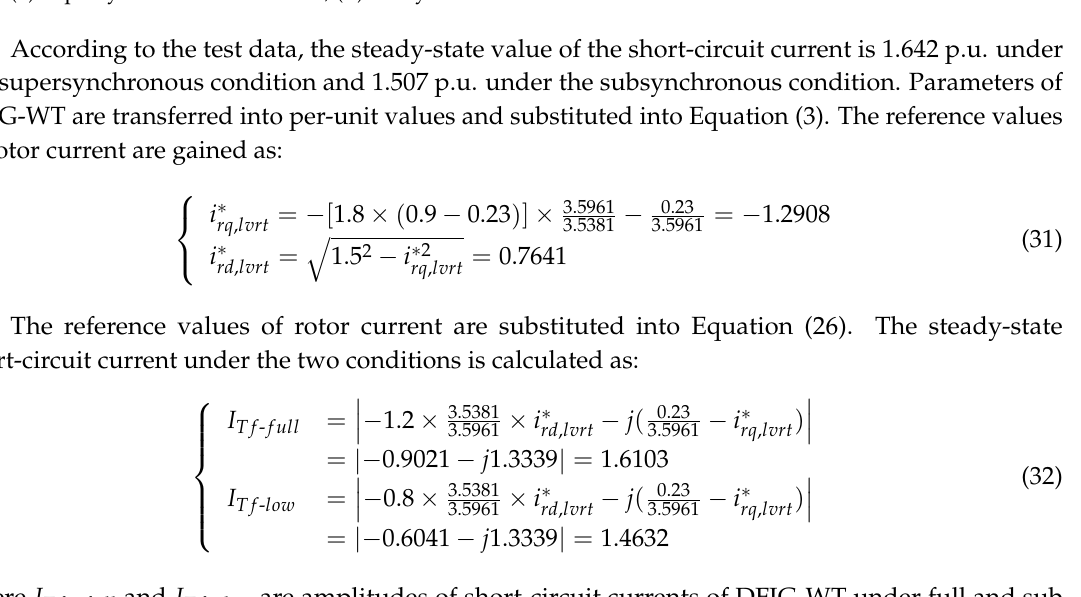
Figure 14. Comparison between recorded data and calculated data under two operating conditions: ( a ) supersynchronous condition; ( b ) subsynchronous condition.